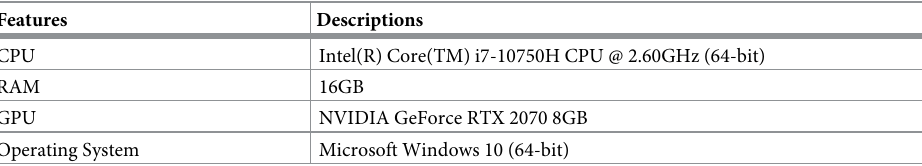
Table 2. Computer